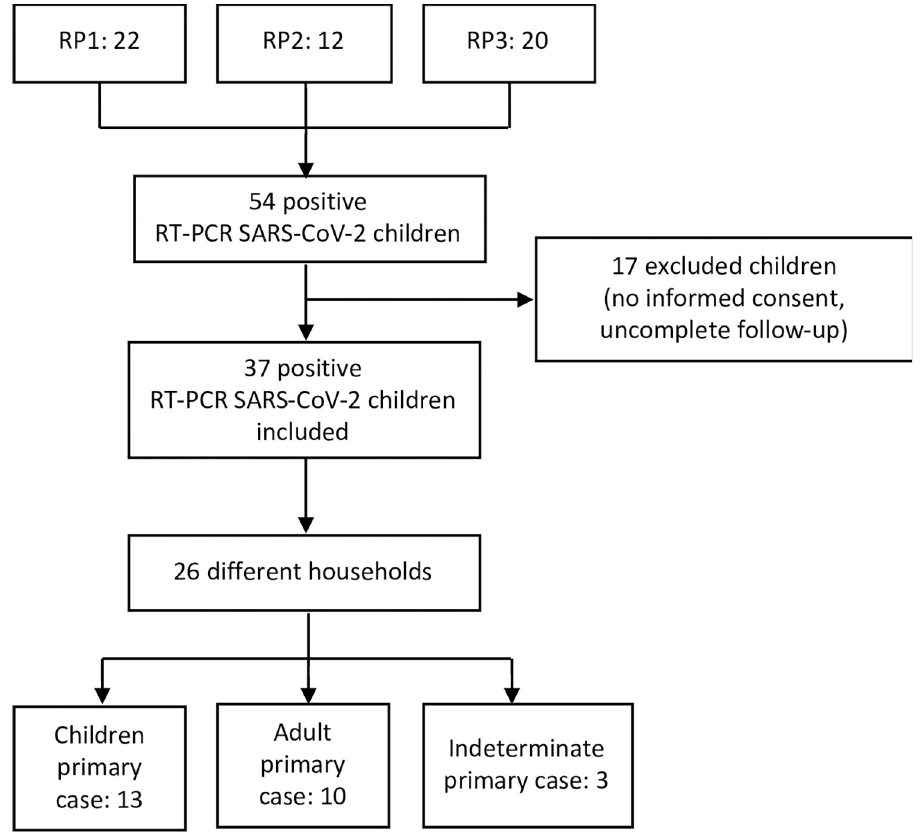
Fig 3. Flowchart including the different recruitment pathways, children included and excluded, and results after the contact tracing in the different family clusters.